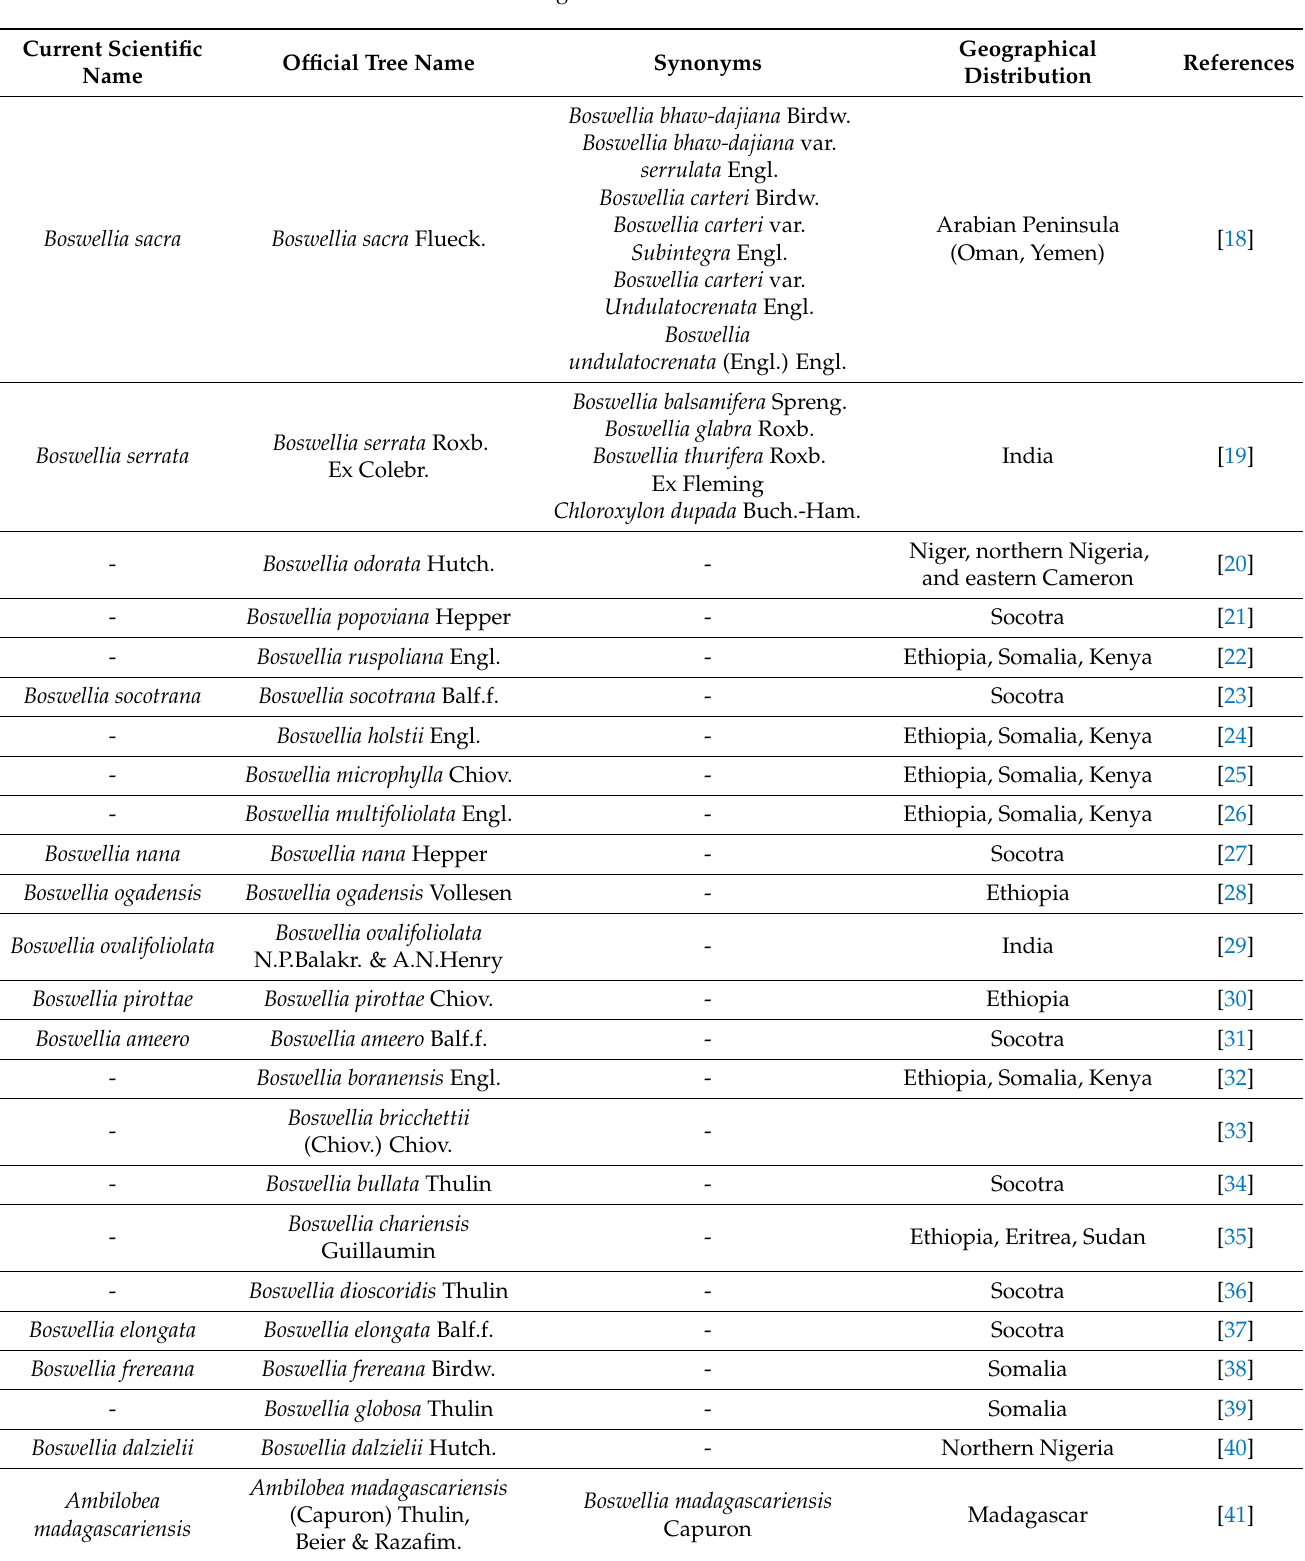
Table 1. List of the current scientific name, official tree name, synonyms, geographical distribution, and references according to the “The World Flora Online